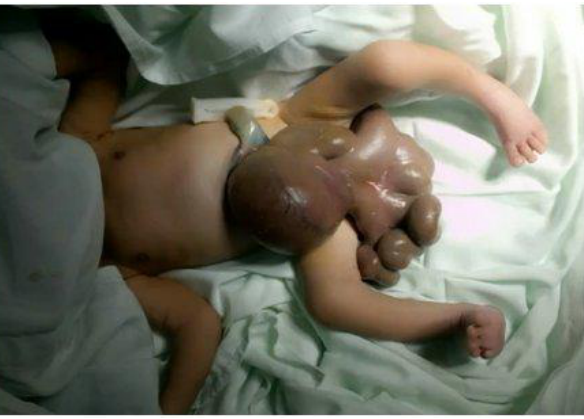
Figure 1: Index patient with giant gastroschisis.